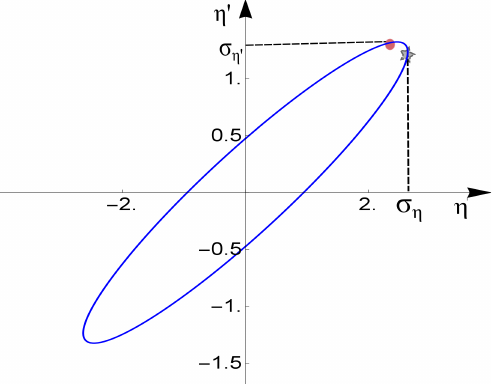
Figure 8. Courant-Snyder ellipse, γ 2 η η 2 − 2 α η ηη (cid:48) + β η η (cid:48) 2 = (cid:101) η . The abscissa of the point denoted by a dot yields the rms of the e-beam angular divergence, the ordinate of the point denoted by a star yields the associated rms transverse